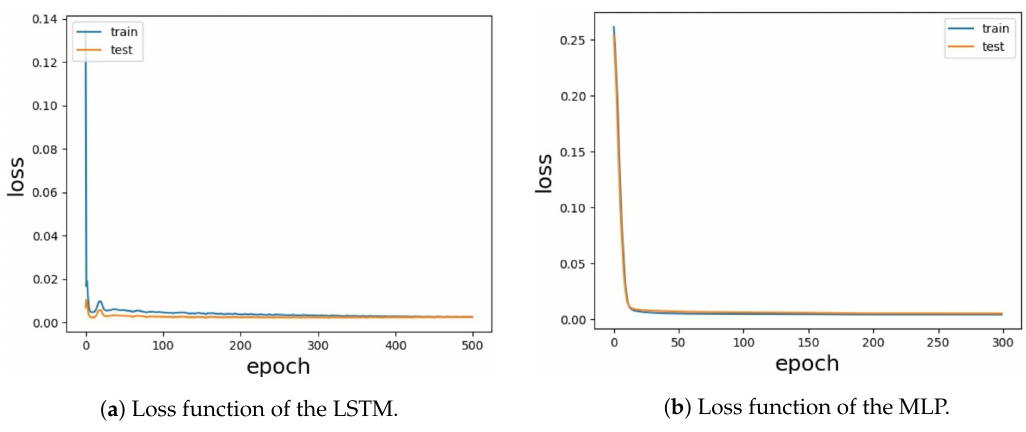
Figure 13. Loss function for SMP prediction with summer data.